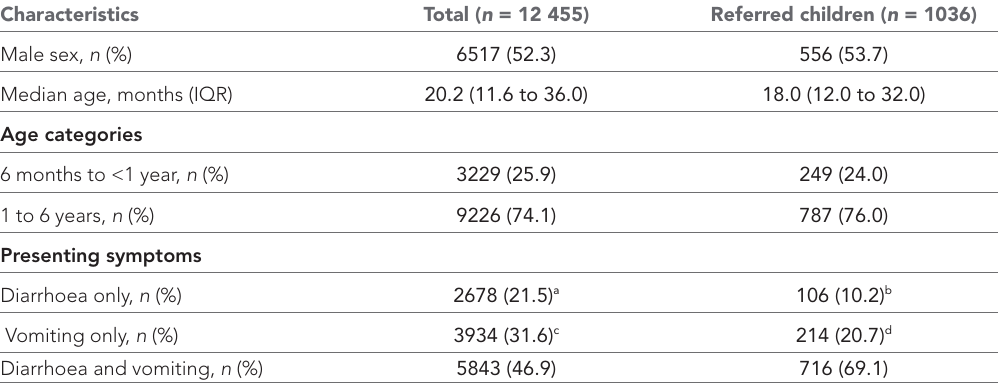
Table 1 Characteristics of Dutch children aged 6 months to 6 years with acute gastroenteritis who were seen in a primary care out- of- hours service